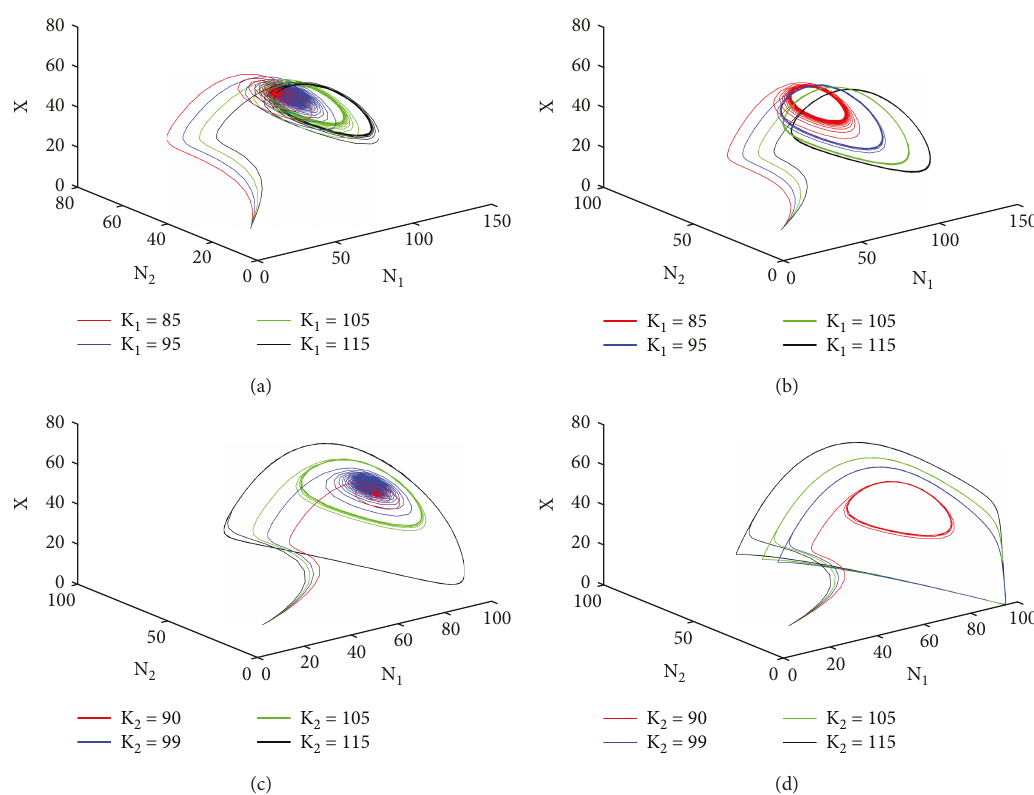
τ = 0 2 , (b) K 1 at 0